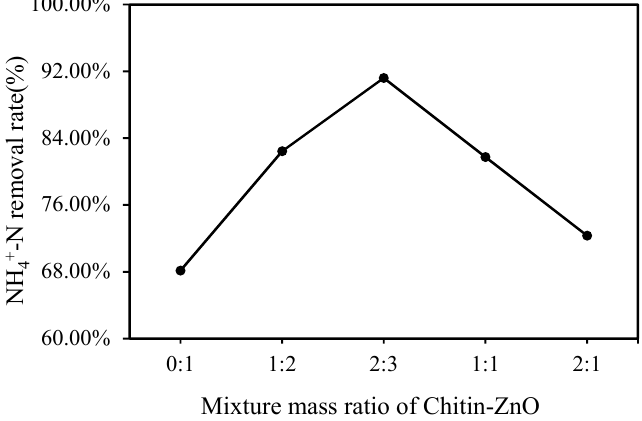
Figure 4. The effect of the mixture mass ratio of Chitin–ZnO.